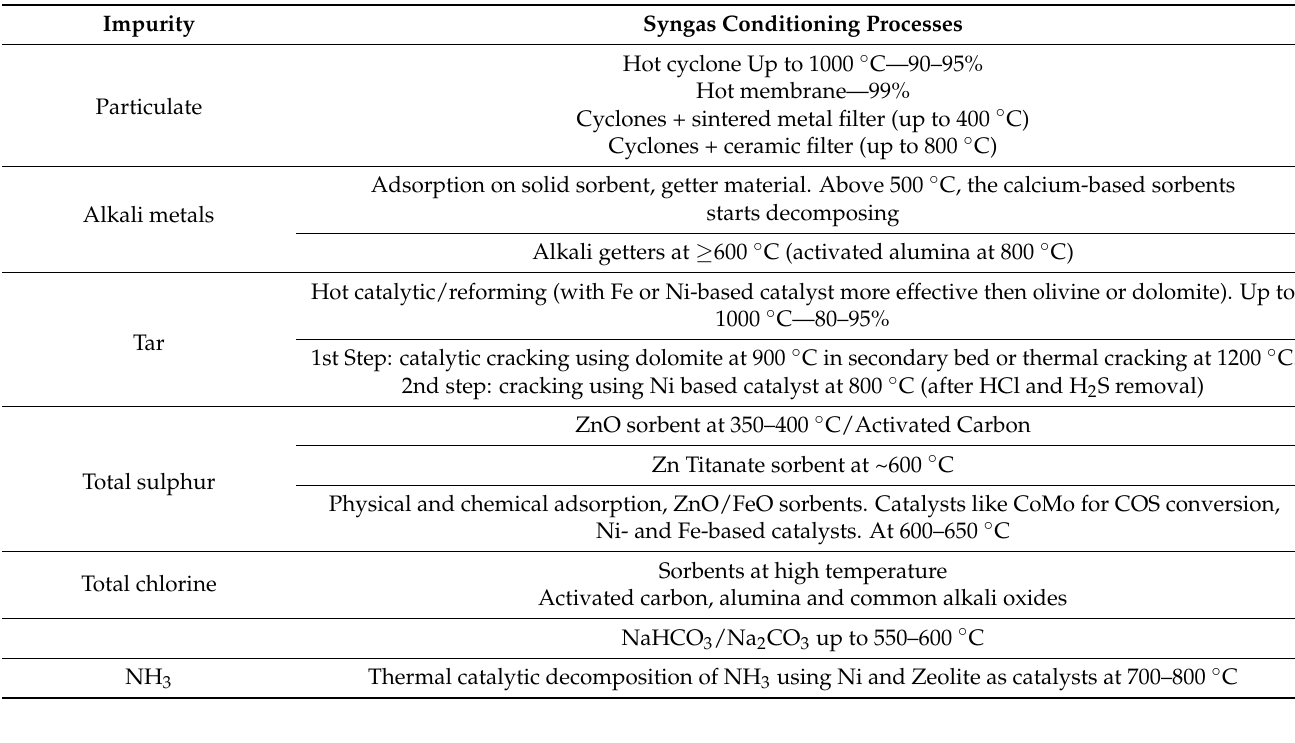
Table 6. Hot syngas cleaning and conditioning processes [2,55,62].